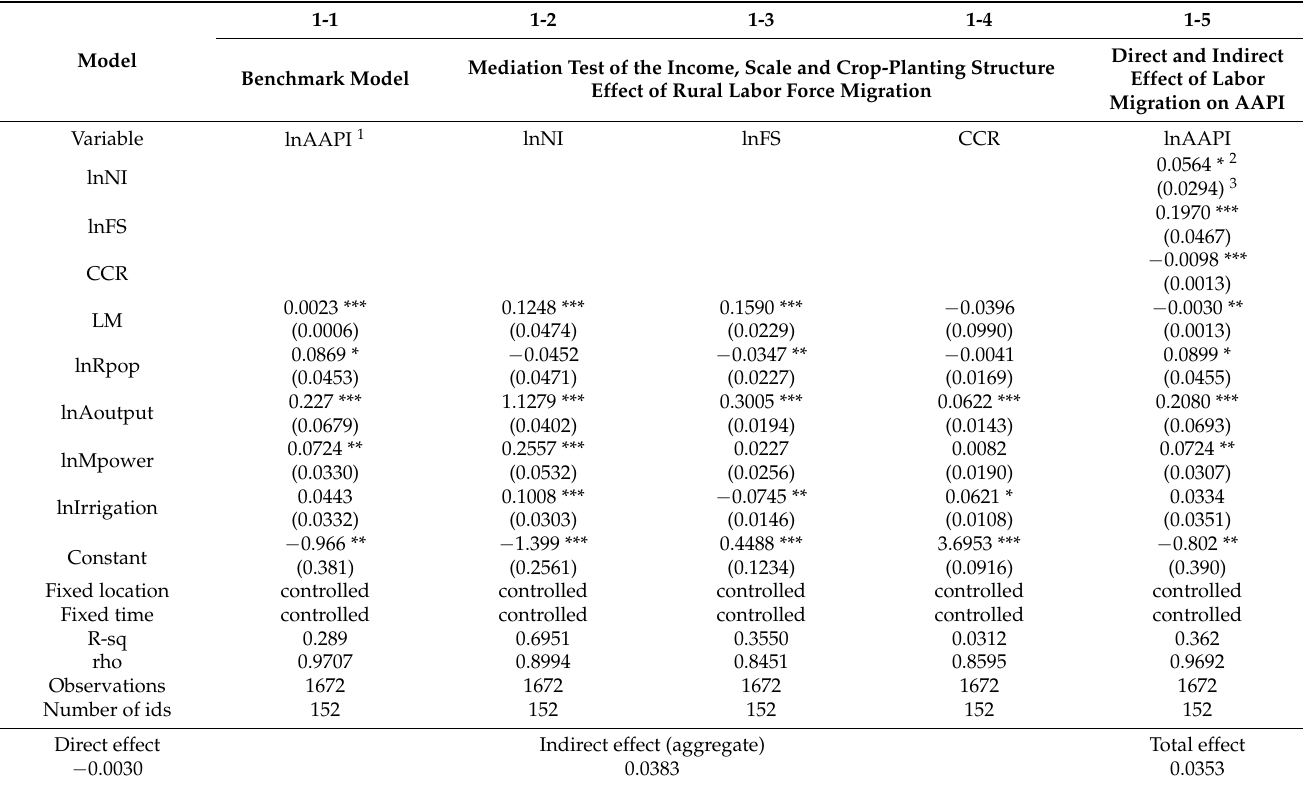
Table 3. Results of mediating effect model